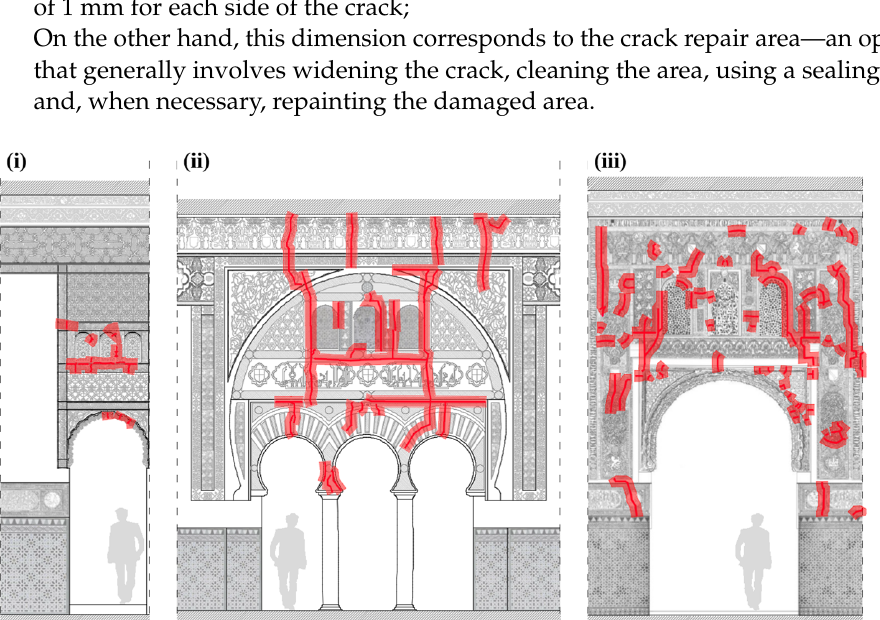
Figure 3. Representation of the areas of influence of the cracking in order to quantify this